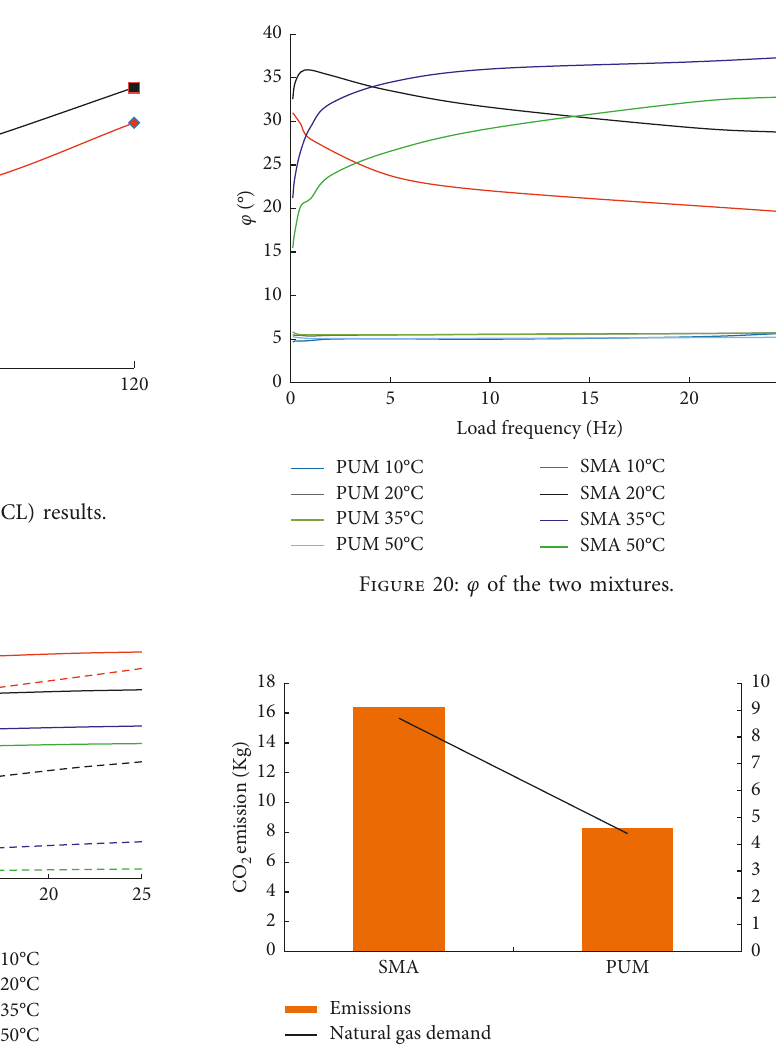
2 emission per ton